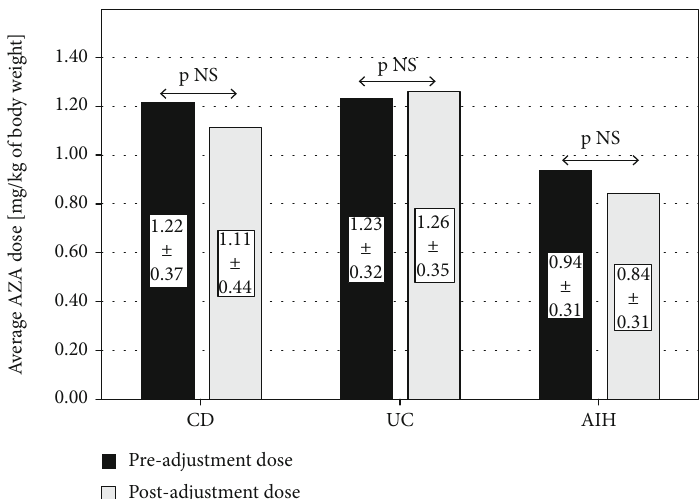
Figure 4: The di ff erence between pre- and postadjustment AZA doses, both in IBD (CD, UC) and AIH subjects. AZA: azathioprine; CD: Crohn ’ s disease; UC: ulcerative colitis; AIH: autoimmunological hepatitis.